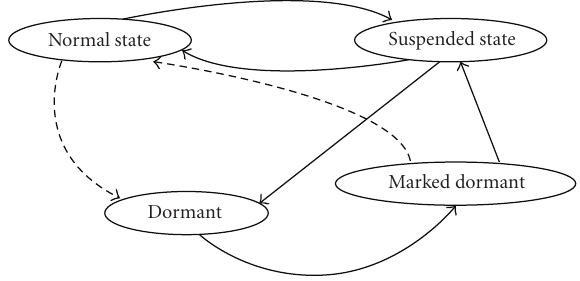
Figure 1: A neighbouring node of a peer in di ff erent